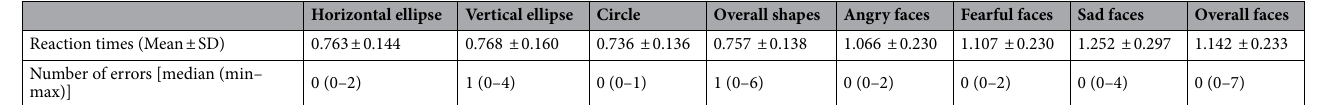
Table 2. Behavioural outcomes of the FERP. Reaction times in seconds for correct trials (mean, SD) and number of errors [median (min–max)] for all conditions during the Emotional Face Assessment Task are presented.